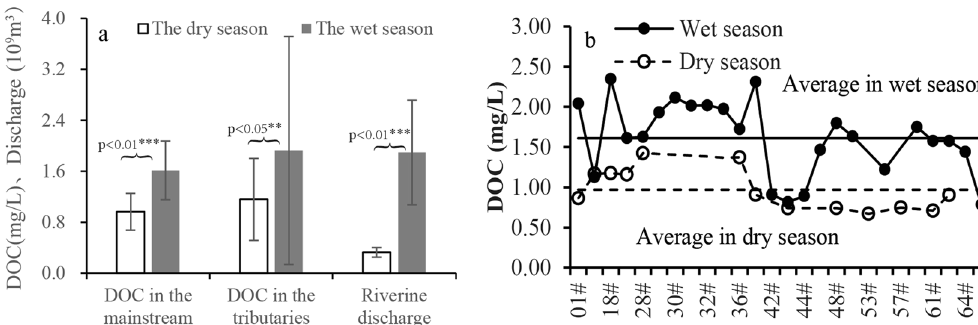
Figure 3. The seasonal difference of riverine DOC concentration and discharge and those spatial variation in the